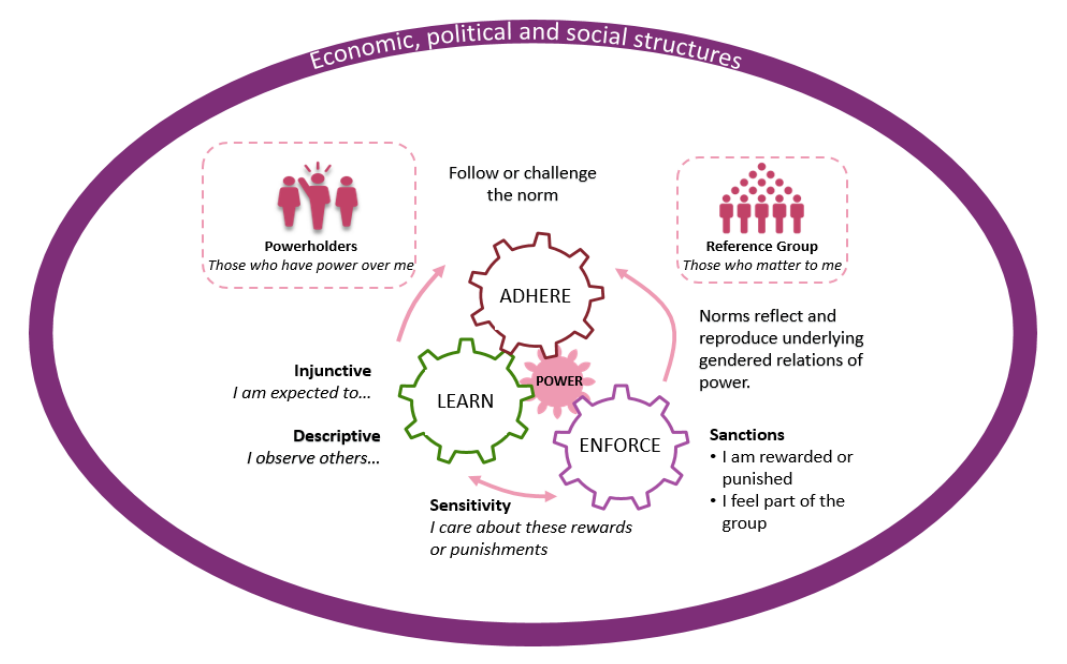
Figure 2c: Description of the Learn-Adhere-Enforce Social Norms Conceptualization